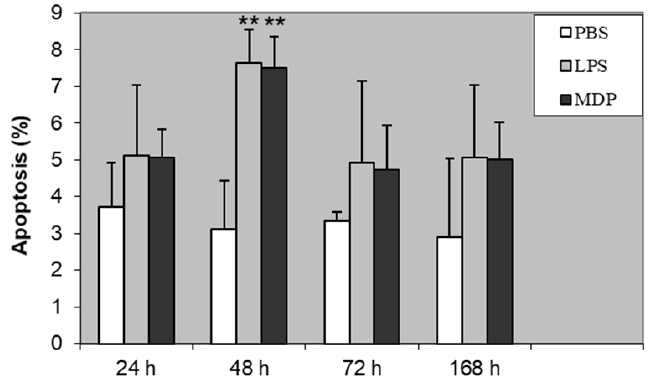
Figure 1. The proportion of apoptotic lymphocytes following induction of bovine mammary glands with PBS (control), LPS, and MDP. Statistically significant differences between control (PBS) and LPS or MDP is marked with asterisks (** P < 0.01).